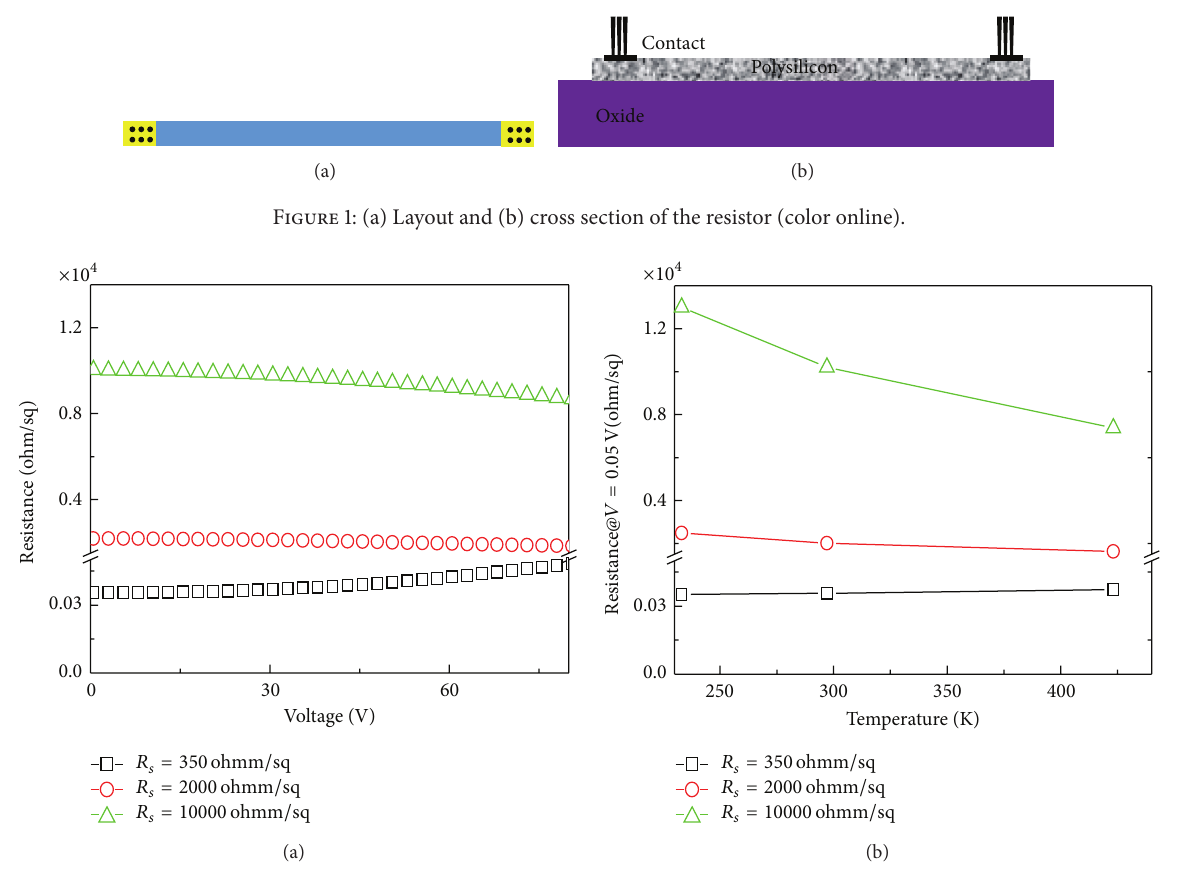
Figure 2: (a) Resistance-voltage and (b) resistance-temperature curves of three resistors with different resistances (color online).